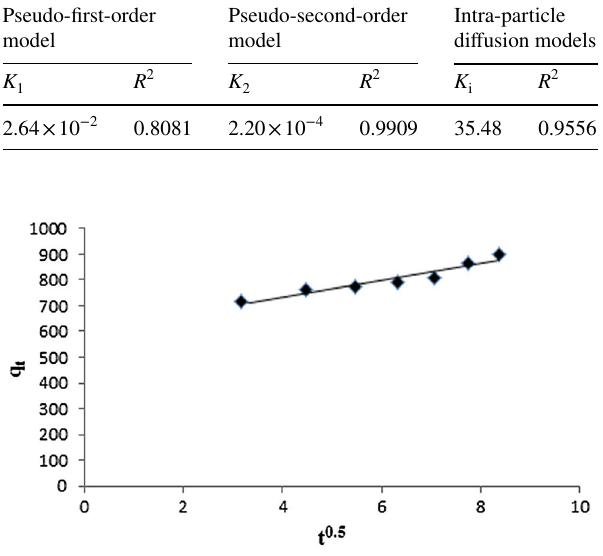
Fig. 4 Intra-particle diffusion model for RHB-ABPC